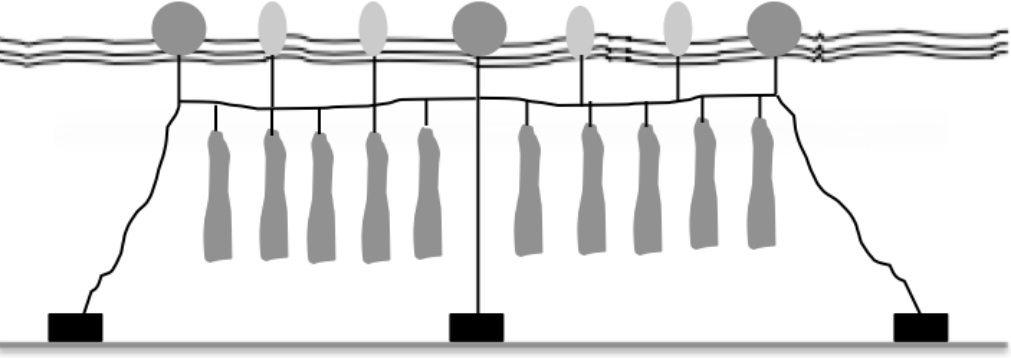
Figure 1. The long-line system mainly utilized in the Mediterranean Sea.